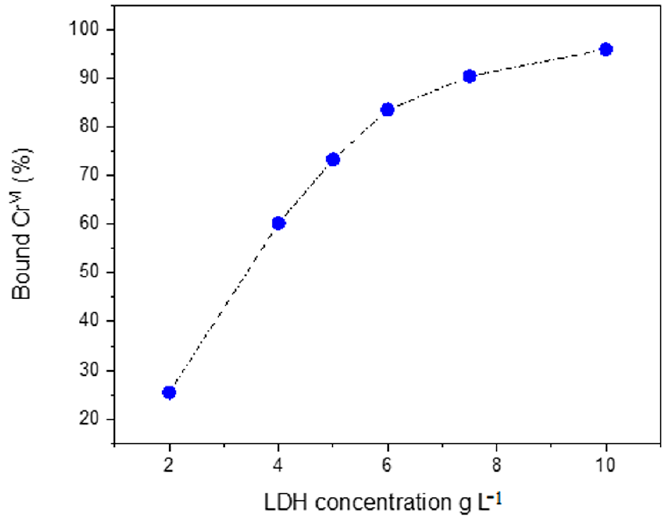
Figure 4. Percentage of adsorbed chromium vs. the LDH concentration in an 80 ppm C(VI) solution. The selected design was the face-centered central composite design (CCD), which explores the factors at three levels [28]. A total of 34 experiments were performed, consisting of two distinct replicates of 14 conditions and 6 replicates of condition 15, i.e., the center point (Table 1). Table 1. Experimental conditions of the adsorption tests performed.